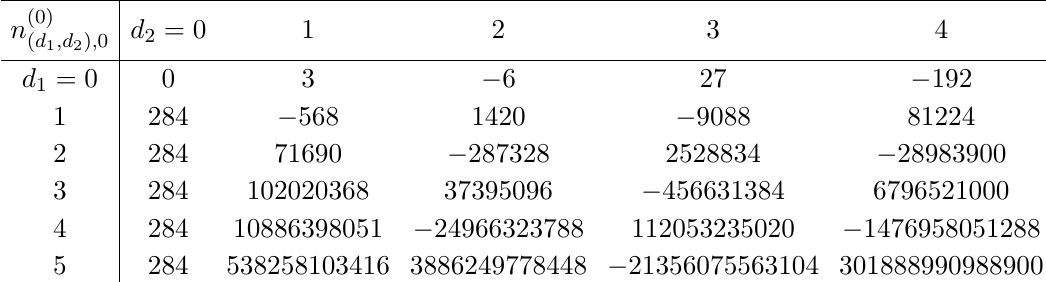
Table 6 . Genus 0 torsion refined Gopakumar-Vafa invariants with Z 2 charge 0 .